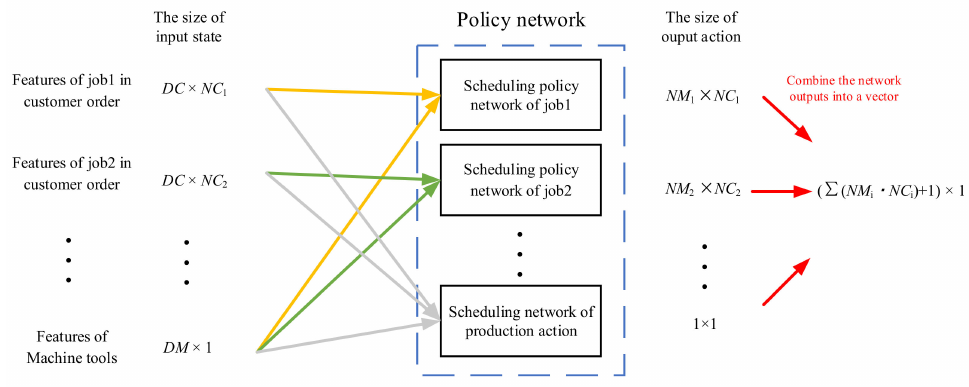
Figure 4. The structure of proposed neural